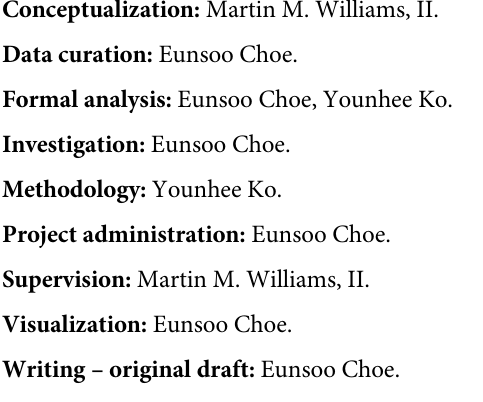
S2 Table. List of maize abiotic stress genes commonly identified from Plant Stress Gene Database. S3 Table. List of DEGs involved in crowding stress response and corrsponding crowding stress tolerance co-expression networks (WGCNA module) identified from previous study [31]. S1 Fig. Hierarchical cluster analysis